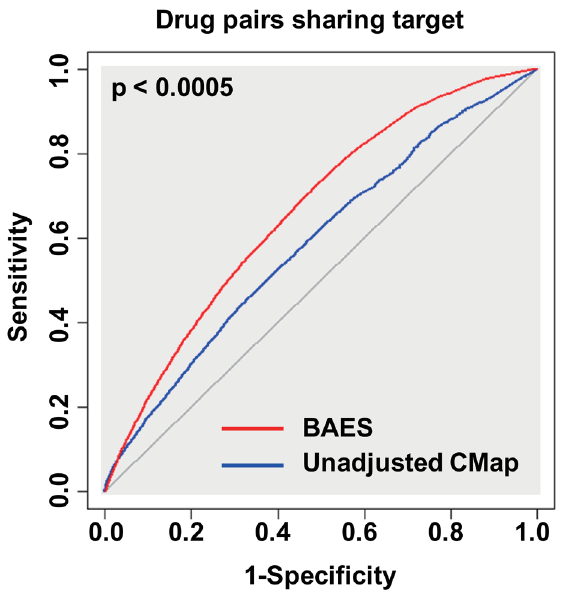
Figure 3. Receiver operating characteristic (ROC) curve is used to evaluate the performance of BAES score and unadjusted CMap expression similarity. For the classification between com- pound pairs sharing target (positive set) or not (negative set), the area under curve for BAES and unadjusted CMap is 0.66 and 0.59, respectively. The advantage of BAES is verified with 2000 replicates of bootstrap test, by the pROC package for R (http://cran.r-project.org/ web/packages/pROC/).